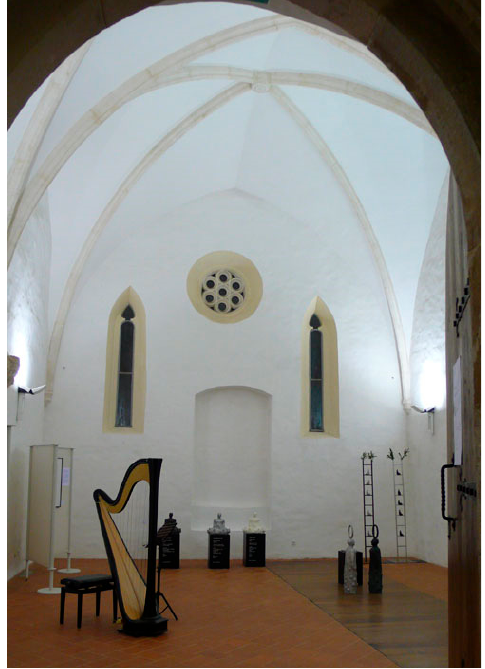
Figure 10. Maribor (Krista Titz-Tornquist, used with permission).